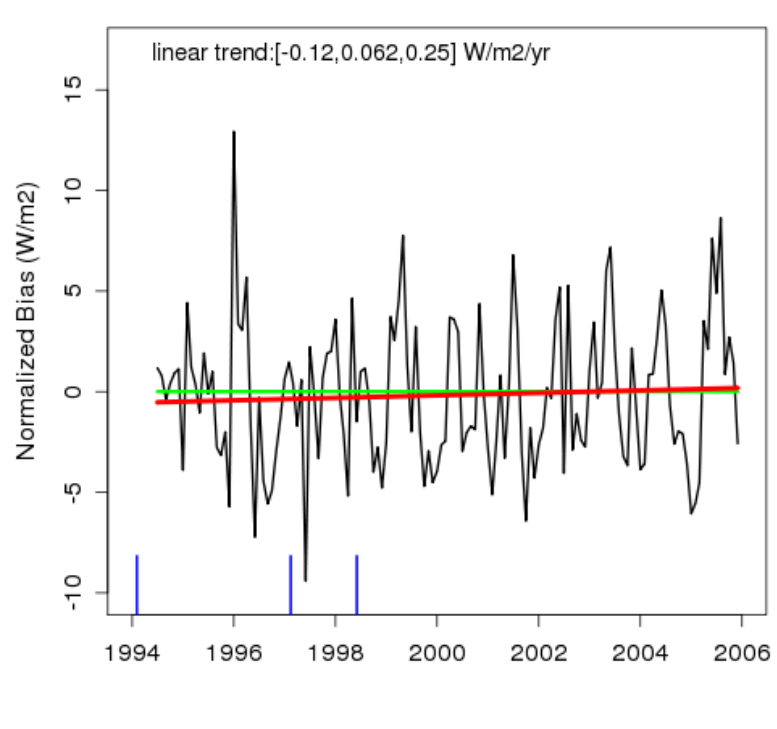
Figure 4. Temporal evolution of the normalised bias between the CM SAF data set and the BSRN data including the trend colored in red. The green line is the neutral axis. The blue lines at the bottom of the plot indicate the change of satellites (Meteosat-5, Meteosat-6, Meteosat-7). The slight trend is statistically not significant, hence no significant trend is apparent. The absence of a significant trend in relation to the large trends in the digital satellite counts (see Figure 5) demonstrates that the self-calibration works